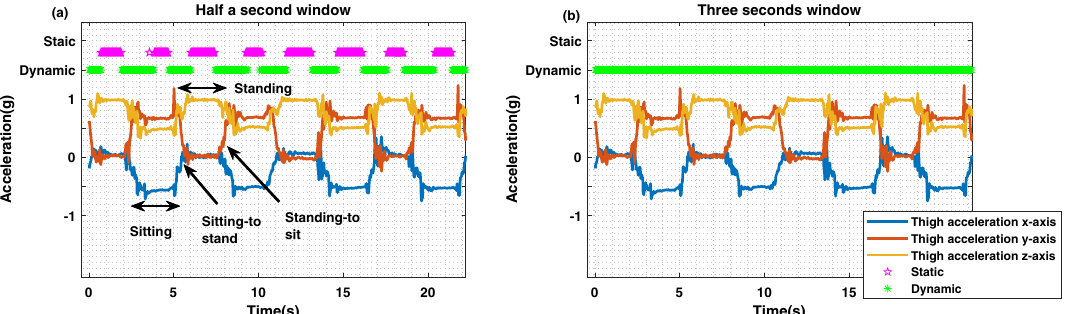
Figure 3. Classification outputs for a 0.5 s window (left) compared with a 3 s window (right), trained using the standard deviation of the magnitude of the thigh data. The plots show the 3-axes of acceleration from a sensor on the thigh as one participant performs 4 sit-to-stand cycles. The classifier outputs are shown at the top of each plot. For a 0.5 s window, the classifier identifies periods of static postures and dynamic movements within each sit-to-stand movement. In contrast, for a 3 s window, the whole segment is classified as a dynamic